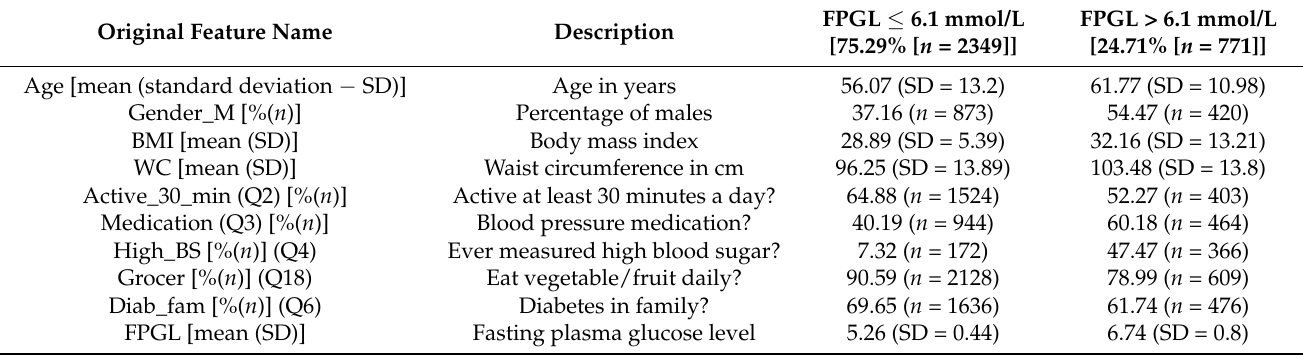
Table 1. Summary table basic predictive and target features for healthcare